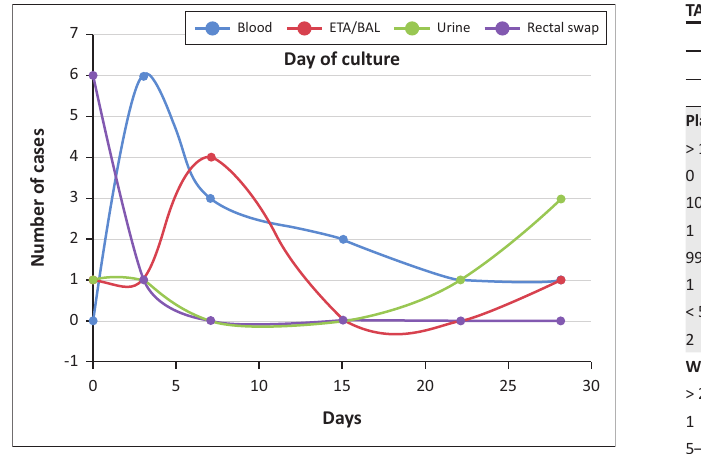
FIGURE 1: Comparing date to positive culture for different specimens type.